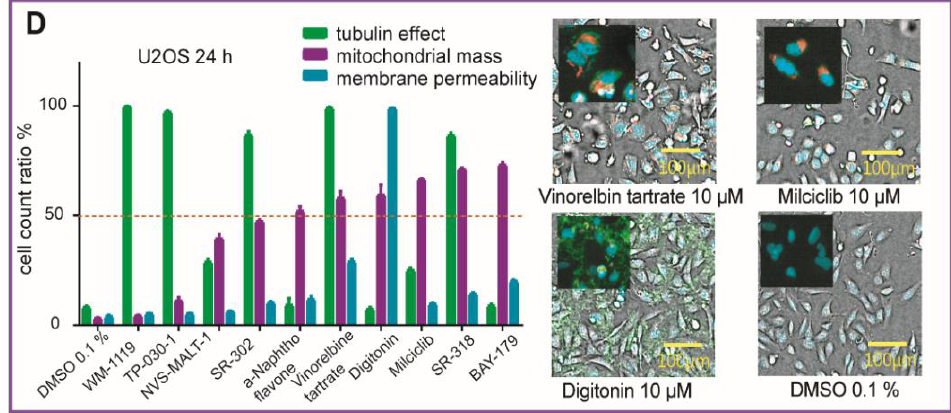
Figure 4. High Content Multiplex screen of different compounds in U2OS cells. ( A ) General workflow of Multiplex High Via protocol analysis with property thresholds. ( B ) Ratio of Hoechst High Intensity Objects after 24 h of compound exposure (Supplementary Table S5) in U2OS in comparison to DMSO 0.1% of biological duplicates. Error bars show SEM of technical triplicates. Property threshold at 50% marked red. For example, fluorescence confocal images of stained (blue:DNA/nuclei, Hoechst33342) U2OS cells after 24 h of exposure to camptothecin 10 µ M in comparison to DMSO 0.1%. ( C ) Cell count ratio of different Nuclei gating after 24 h of 10 µ M of compound exposure (Supplementary Table S5) in comparison to DMSO 0.1% in U2OS cells. Error bars show SEM of technical triplicates. Property threshold at 50% marked red. Brightfield confocal image of stained (blue: DNA/nuclei, green: Microtubule different, red: mitochondria content, magenta: Annexin V apoptosis marker) U2OS cells after 24 h of compound exposure of staurosporine 10 µ M) in comparison to DMSO 0.1%. Gating of cells for Nuclei gating and Annexin V based gating shown. ( D ) Cell count ratio of tubulin effect (green), mitochondrial mass increase (magenta) and membrane permeability (blue) of U2OS cells after 24 h of 10 µ M of compound exposure (WM-1119, TP-030-1, NVS-MALT-1, SR-302, α -naphthoflavone, vinorelbine tartrate, digitonin, milciclib, SR-318, BAY-179) in comparison to DMSO 0.1%. Error bars show SEM of technical triplicates. Property threshold at 50% marked. Brightfield confocal image of stained (blue: DNA/nuclei, green: microtubule different, red: mitochondria content, magenta: Annexin V apoptosis marker) U2OS cells after 24 h of compound exposure (vinorelbine tartrate 10 µ M, milciclib 10 µ M, digitonin 10 µ M) in comparison to DMSO 0.1%. Fluorescent image of different staining is